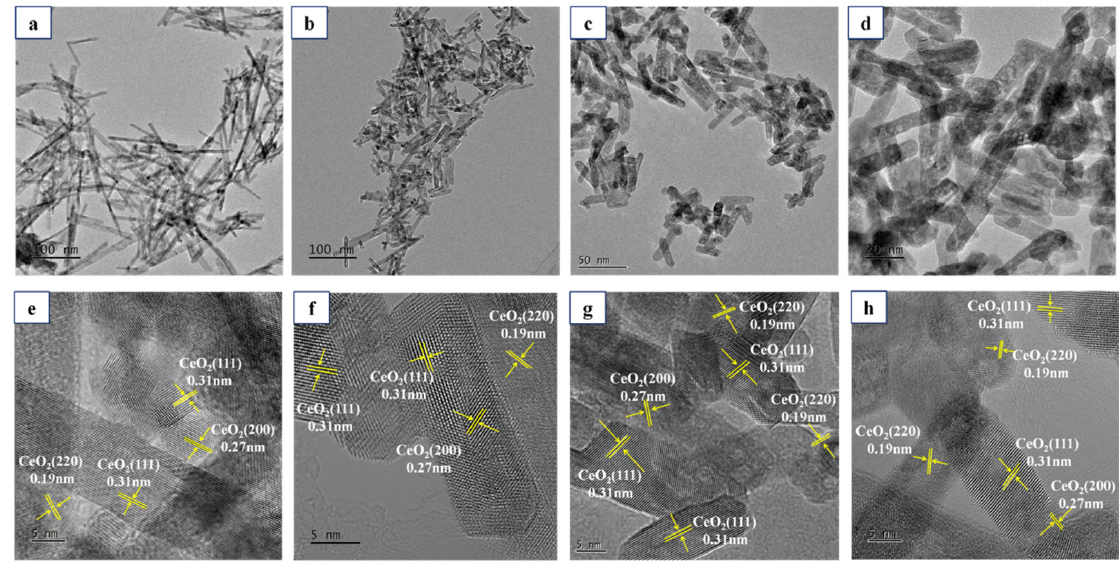
Figure 2. TEM images of ( a ) CeO 2 , ( b ) Ce 0.9 Zr 0.1 O 2 , ( c ) Ce 0.8 Zr 0.2 O 2 and ( d ) Ce 0.7 Zr 0.3 O 2 ; HRTEM images of ( e ) CeO 2 , ( f ) Ce 0.9 Zr 0.1 O 2 , ( g ) Ce 0.8 Zr 0.2 O 2 , and ( h ) Ce 0.7 Zr 0.3 O 2 .